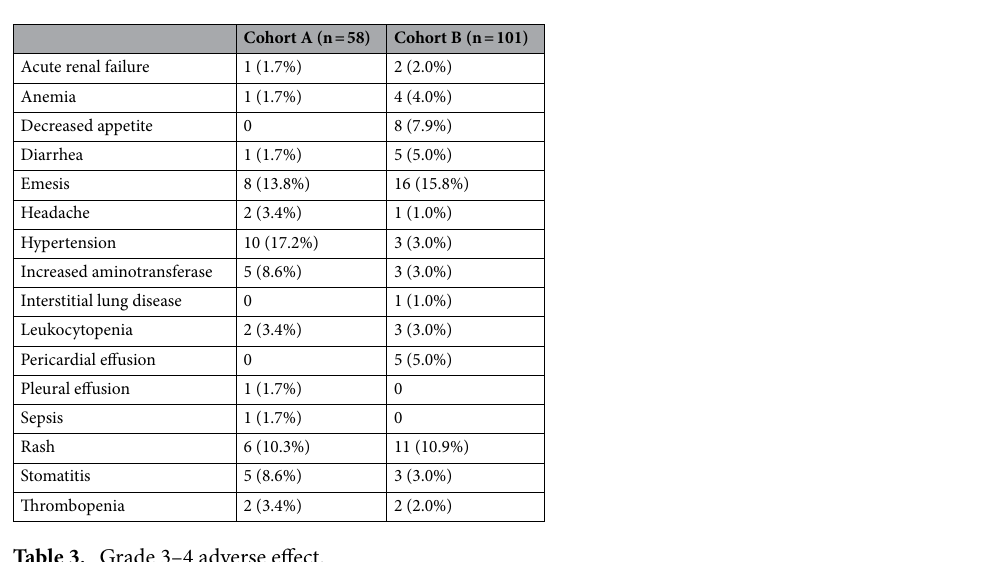
Table 3. Grade 3–4 adverse